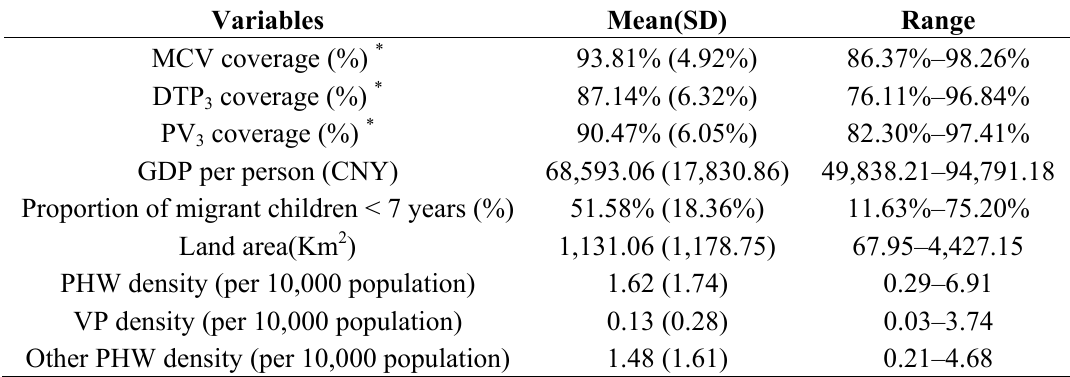
Table 2. Description analysis of dependent and independent